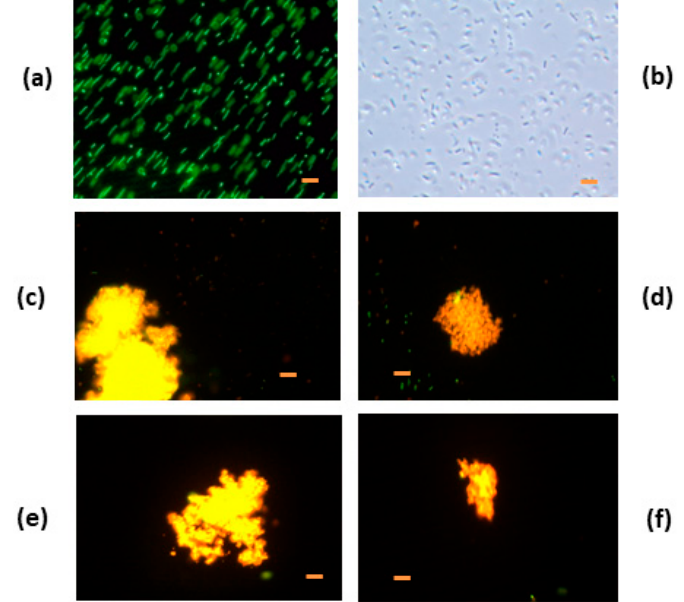
Figure 7. Fluorescence micrographs of Escherichia coli incubated with denatured hen egg white lysozyme (HEWL)-DTT for 1.0 h, 1.5, 2.0, and 4.0 h of incubation ( a ) E. coli control without HEWL, ( b ) E. coli control without HEWL without fluorescence, ( c ) E. coli incubated with HEWL/DTT 1.0 h, ( d ) E. coli incubated with HEWL/DTT 1.5 h, ( e ) E. coli incubated with HEWL/DTT 2.0 h, and ( f ) E. coli incubated with HEWL/DTT 4.0 h. Bacteria control and bacteria with sample were incubated for 15 h at 0.5 mg/mL. Bar = 2 μ m.